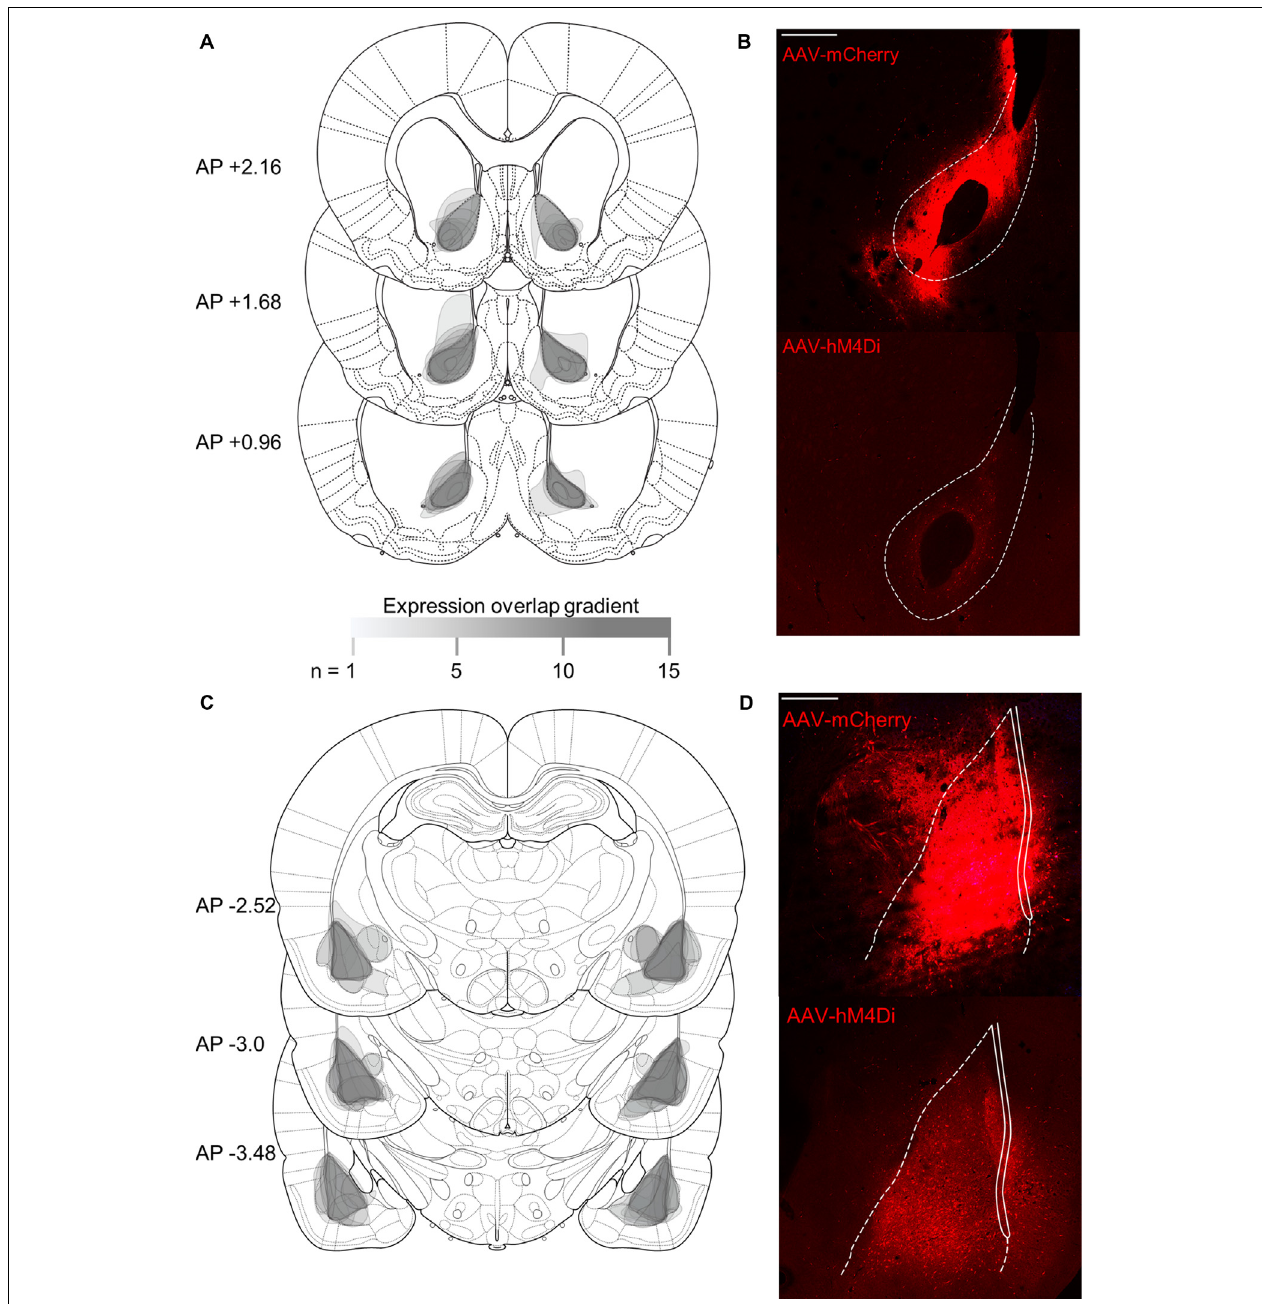
FIGURE 4 | Histological verification of viral expression in NAc core and BLA. Rats were injected with viral constructs unilaterally in BLA and in contralateral NAc core (mm from Bregma; Paxinos and Watson, 2007); scale bars represent 500 µ m. Unilateral expression was counterbalanced, but the expression is shown in both hemispheres. (A) Schematic representation of viral expression and (B) representative image of mCherry (top) and hM4Di (bottom) NAc core expression. (C) Schematic representation of viral expression and (D) representative image of (top) mCherry and hM4Di (bottom) BLA expression. The legend indicates the density of overlapping expression, where ( n ) is the number of overlapping cases to produce the represented